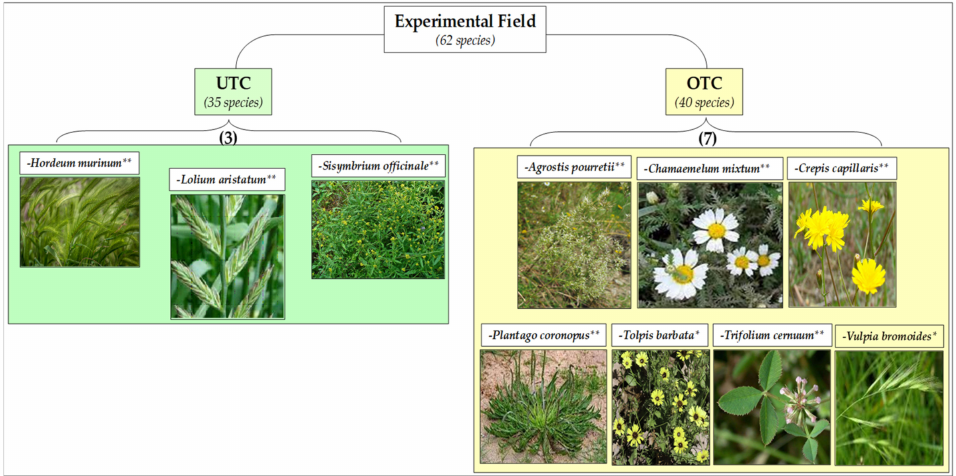
Figure 14. Bio-indicator species of “tree canopy” effect (UTC, under tree canopy; OTC, outside tree canopy). *: Probability < 0.05; **: Probability <